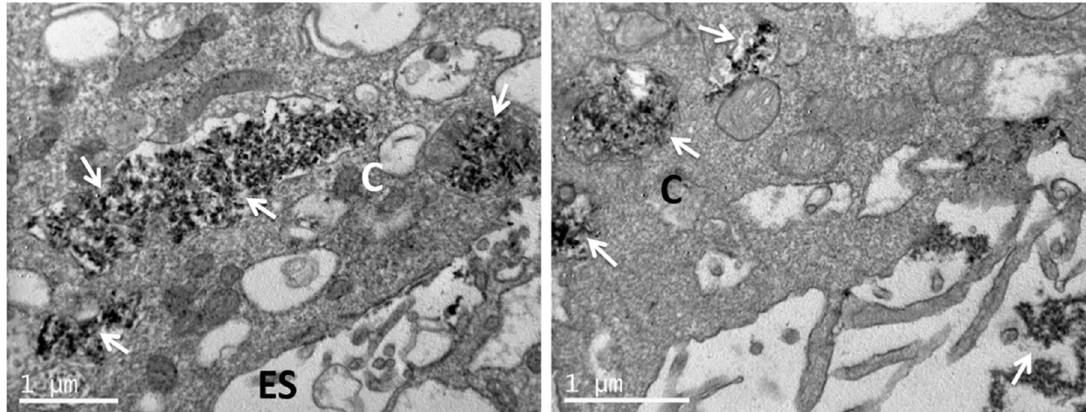
Figure 9. Representative TEM images showing nHA-1 uptaken by pre-osteoblastic cells. Nanoparticles of nHA-1 are shown localized and presented in both the extracellular and the intracellular space in cyst-like structures. The scale bar represents 1 µ m. The letter C designates the cytoplasm and ES the extracellular space. The arrows depict the nanoparticulated sample nHA-1.